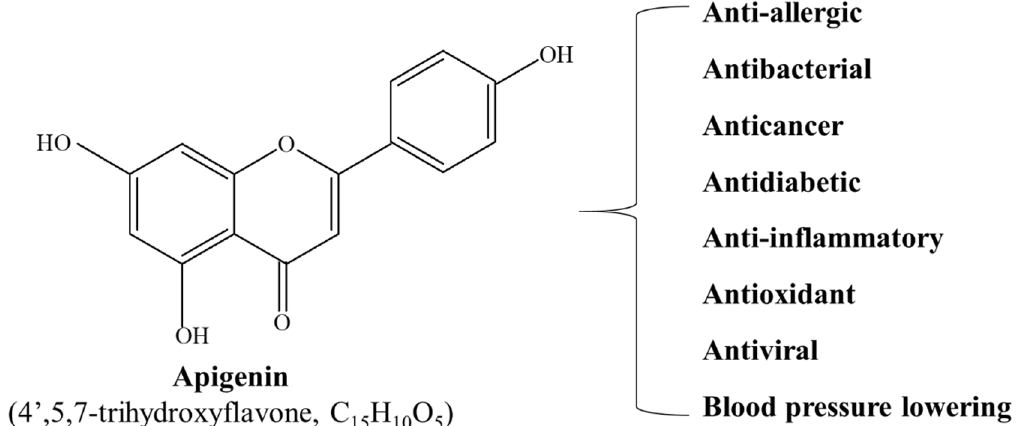
Figure 1. Molecular structure and physiological function of apigenin.